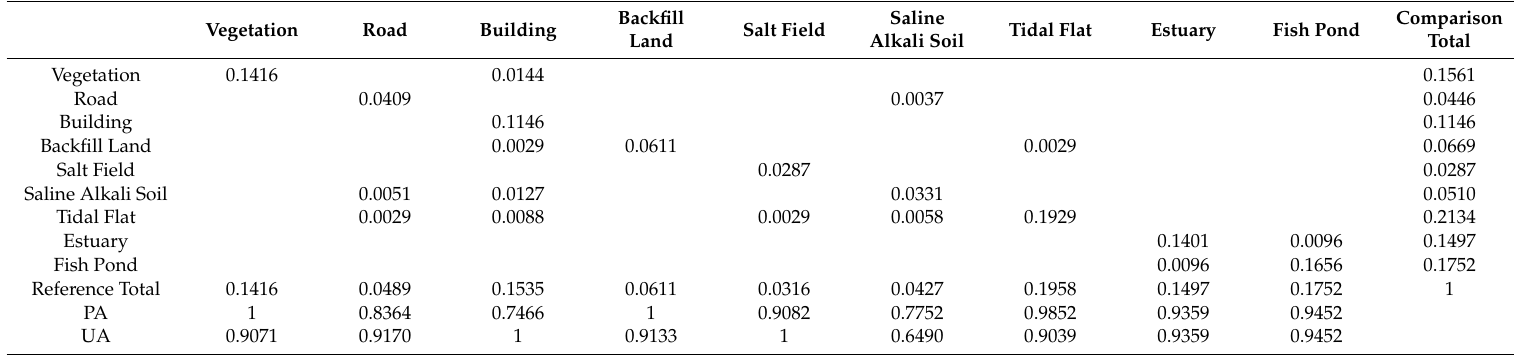
Table 7. Estimated population matrix of the RF method in the WV-2